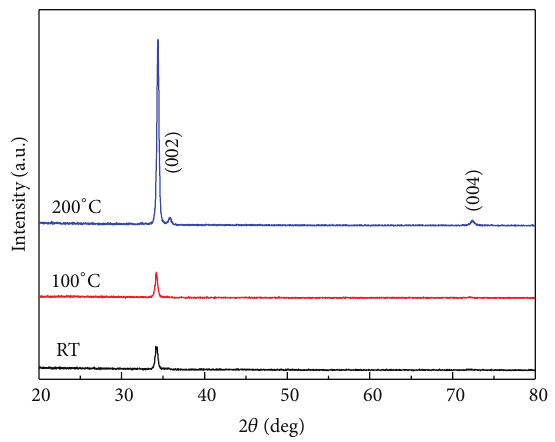
Figure 1: XRD patterns of the GZO thin films as a function of sub- strate temperature.